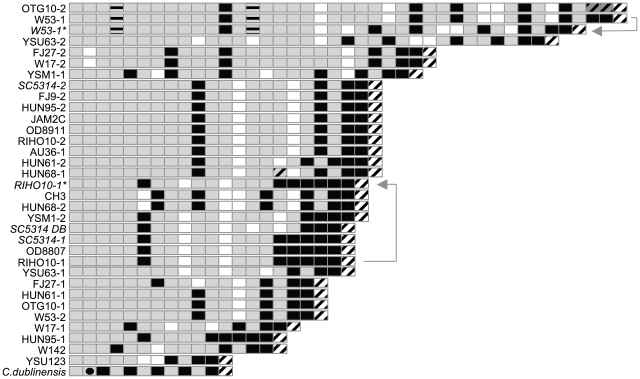
Graphic representation of the amino acid sequences of PNG2 repeat regions.The PNG2 repeat regions of 33 C. albicans strains were sequenced and the predicted amino acid sequences, plus the repeat region from the C. dubliniensis ortholog (gi241951534), were compared. Grey boxes represent the repeat PPHE, black boxes PPHH, and unfilled boxes PPHK. Grey boxes with diagonal black stripes represent PPHP, grey boxes with horizontal black stripes represent SPHE, white boxes with diagonal grey stripes PPPE, white boxes with diagonal black stripes PPHD and checkered boxes PSHH. The C. dubliniensis-specific repeat PGDK is represented by a grey box with a black dot. Where two alleles of the same strain were sequenced, the name of the strain is followed by a dash followed by the allele number (1 or 2, with 1 being the allele with the shorter repeat region). Names of laboratory strains are italicized, including the derivatives of the serially transferred W53 and RIHO10 with altered alleles; the altered alleles are marked by asterisks and linked by an arrow to the allele in the original strain from which they are most likely derived. For laboratory strain SC5314 two alleles sequenced by us, and the sequence determined as part of the C. albicans genome sequencing project, “DB” are shown (both alleles in the genome database are identical in terms of amino acid repeats).